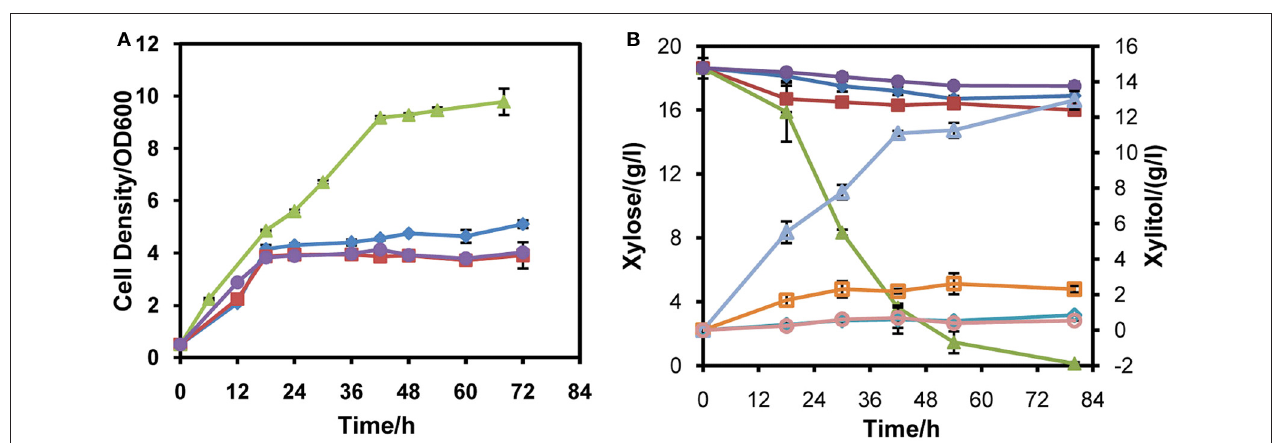
FIGURE 2 | Aerobic xylose consumption of strains W303tAR, W303AR, W303PR, and W303C in YPX medium. (A) growth profiles, (B) xylose consumption and xylitol production. Three promoters were applied to express XYL1 for balance of XYL1 and XYL2 . W303tAR, W303AR, and W303PR harbored truncated ADH1 promoter, intact ADH1 promoter and PGK1 promoter, respectively. W303C was the control strain. The aerobic cell